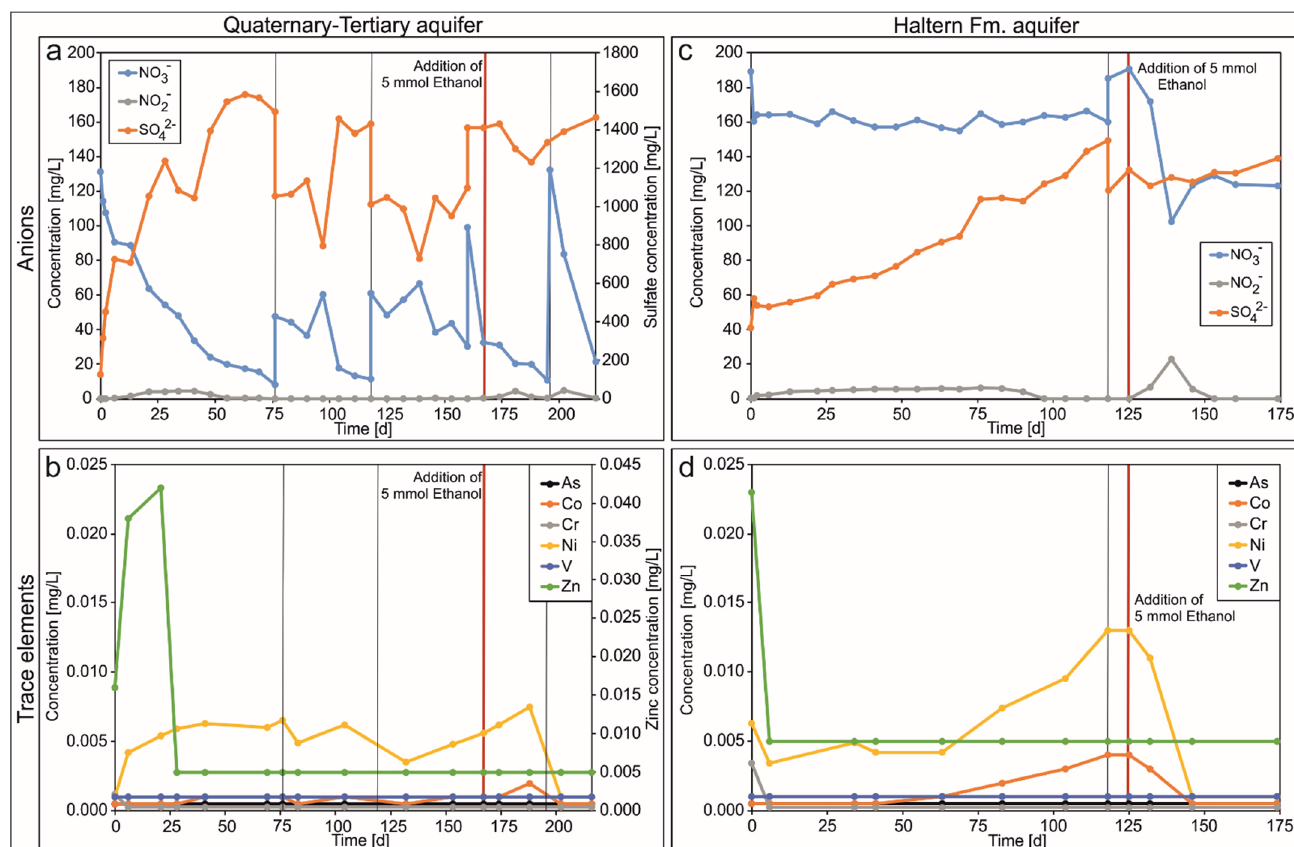
Figure 11. The anion and trace element concentration of circulation column experiments. Left: ( a ) Anions; ( b ) Trace elements of the Quaternary–Tertiary aquifer. Right: ( c ) Anions; ( d ) Trace elements of the Haltern Fm. aquifer, with injection of ethanol marked by red vertical lines and water refill marked by thin black vertical lines.